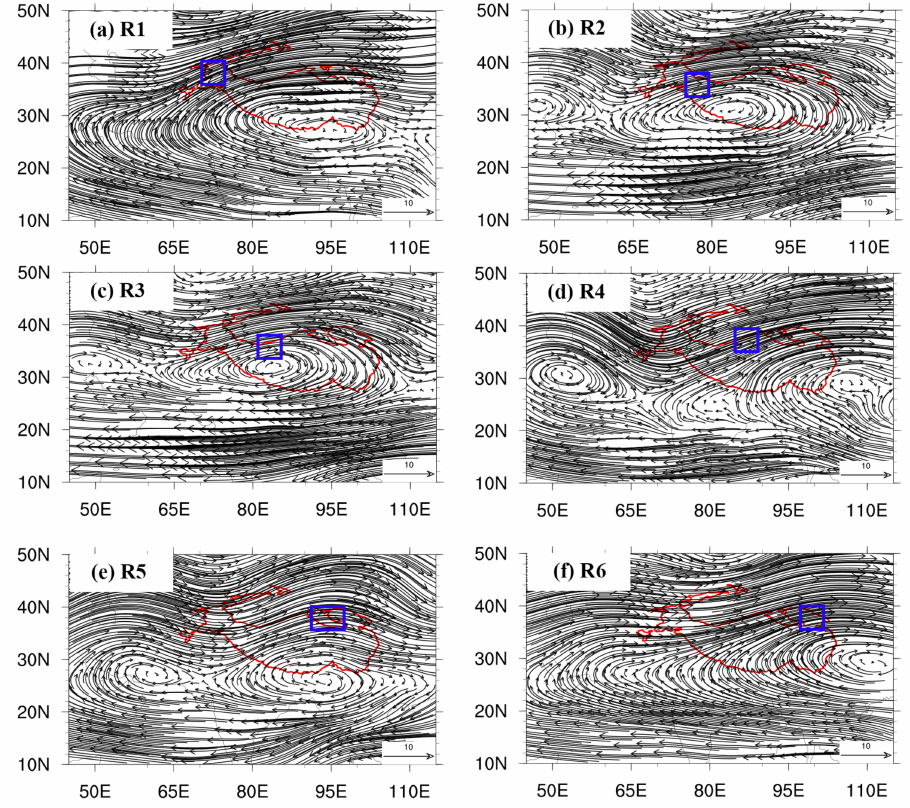
Figure 7. Similar to Figure 6, but at 200 hPa. Blue rectangles in the panels ( a–f ) represent the subregions,